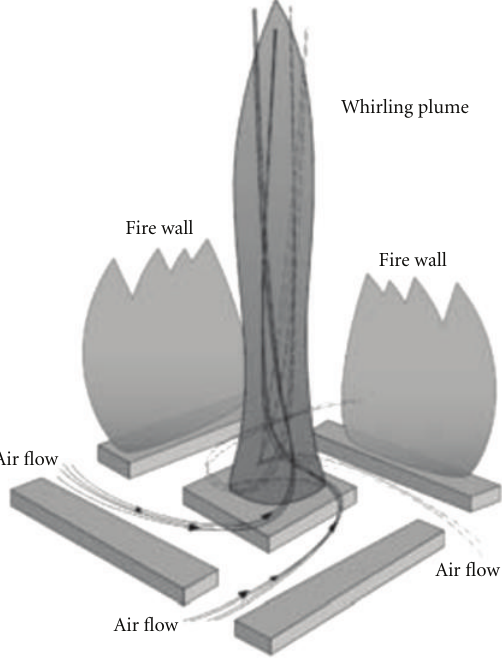
Figure 5: Schematic showing a heat source configuration that can cause a multiple interacting plume-type fire whirl (from Zhou and Wu [23]).